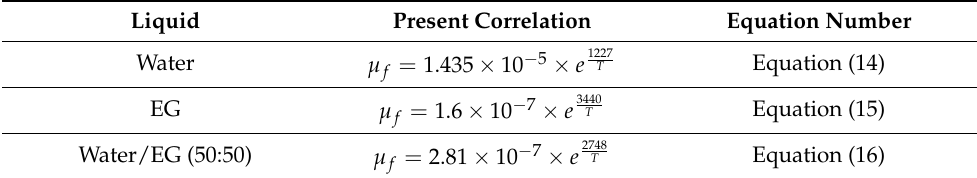
Table 2. Correlations for the dynamic viscosity of the tested fluids.